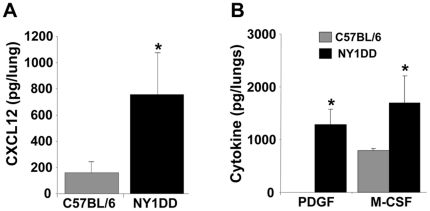
NY1DD SCD mice have increased lung levels of CXCL12 and other cytokines that are relevant to fibrocyte biology.A) demonstrates that the ligand to CXCR4, CXCL12, is markedly elevated in the lungs of NY1DD mice under baseline conditions compared to appropriate strain and age-match mice. B) demonstrates that the growth factor (PDGF) and colony stimulating factor (M-CSF) are significantly elevated in the lungs of NY1DD mice under baseline conditions compared to appropriate strain and age-match mice. N = six mice lungs in each group. * p = <0.05.